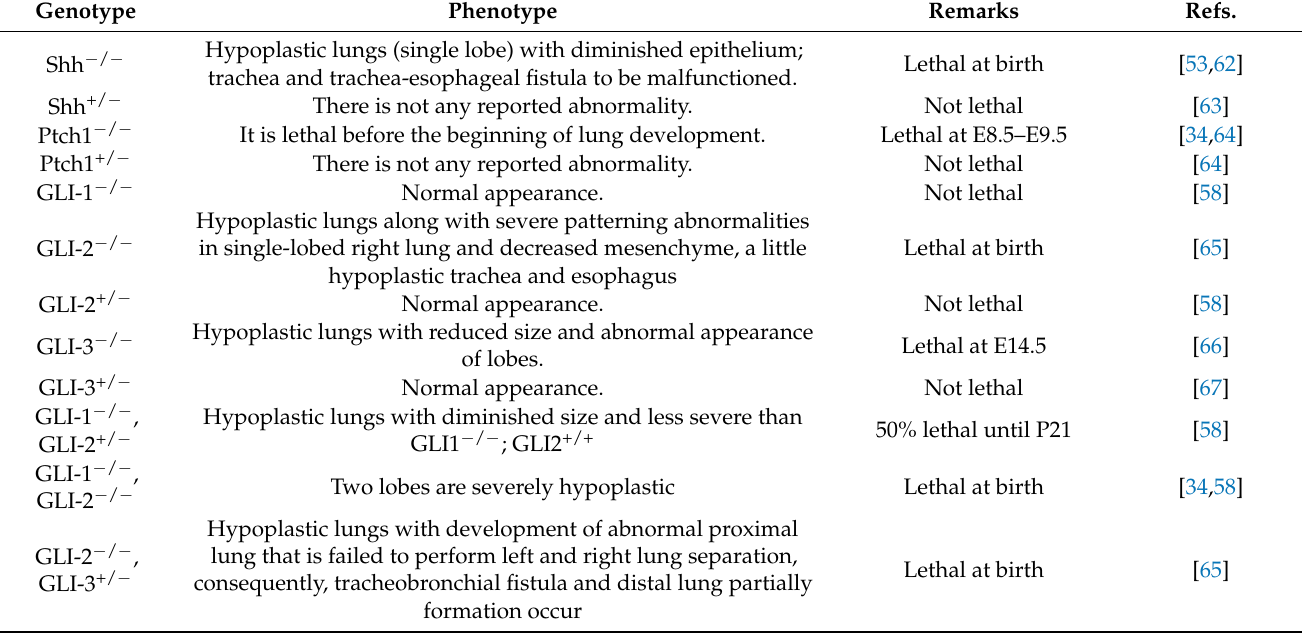
Table 1. Hedgehog signaling pathway gene knockout for lung